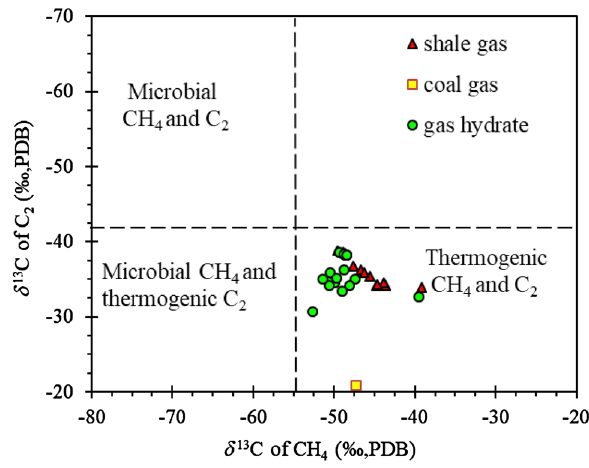
Fig. 9 The d 13 C of methane versus d 13 C of ethane of gas hydrate from Milkov plot. Our data plot in the thermogenic methane and ethane areas. Modified from Milkov (2005) and Bernard et